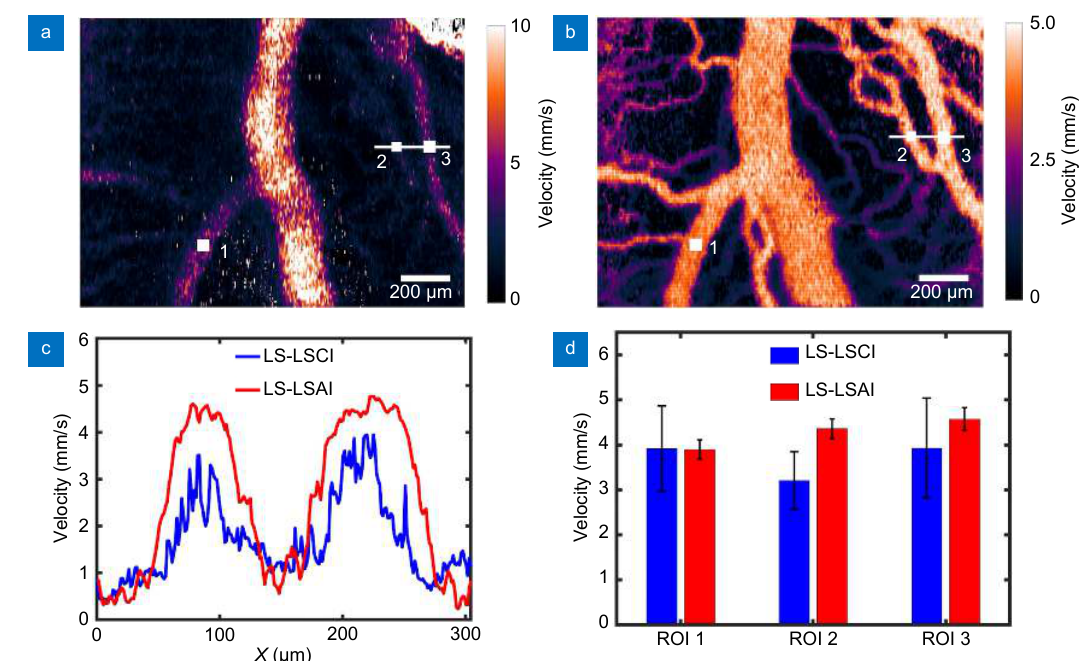
Fig. 5 | Comparison of LS-LSAI and LS-LSCI. The averaged velocity images ( a ) obtained with LS-LSCI with the exposure time of 24 ms and ( b ) LS-LSAI with the exposure time of 0.04 ms. ( c ) The flow velocity profiles taken along the white line in (a) and (b). ( d ) The spatially averaged blood flow velocity and standard deviation at the positions indicated by the white regions of interest (ROI) in (a) and